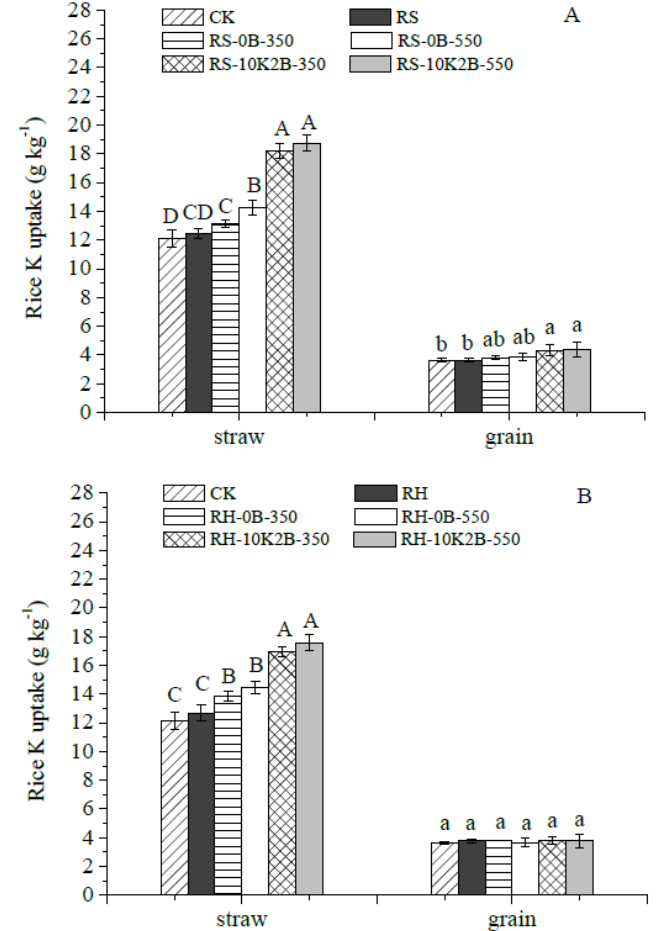
Figure 6. Rice K uptake with alkali-enhanced ( A ) rice straw and ( B ) husk biochar amendment. Note: CK, non-amendment; RS, rice straw; RH, rice husk; RS/RH-0B-350 and RS/RH-10K2B-350 are rice straw/husk biochars prepared with the proportion of K 2 CO 3 to feedstock at 0 and 10 at 350 °C, respectively; RS/RH-0B-550 and RS/RH-10K2B-550 are rice straw/husk biochars prepared with the proportion of K 2 CO 3 to feedstock at 0 and 10 at 550 °C, respectively. Different letters indicate significant differences within treatment ( p < 0.05) based on Duncan’s multiple range test.